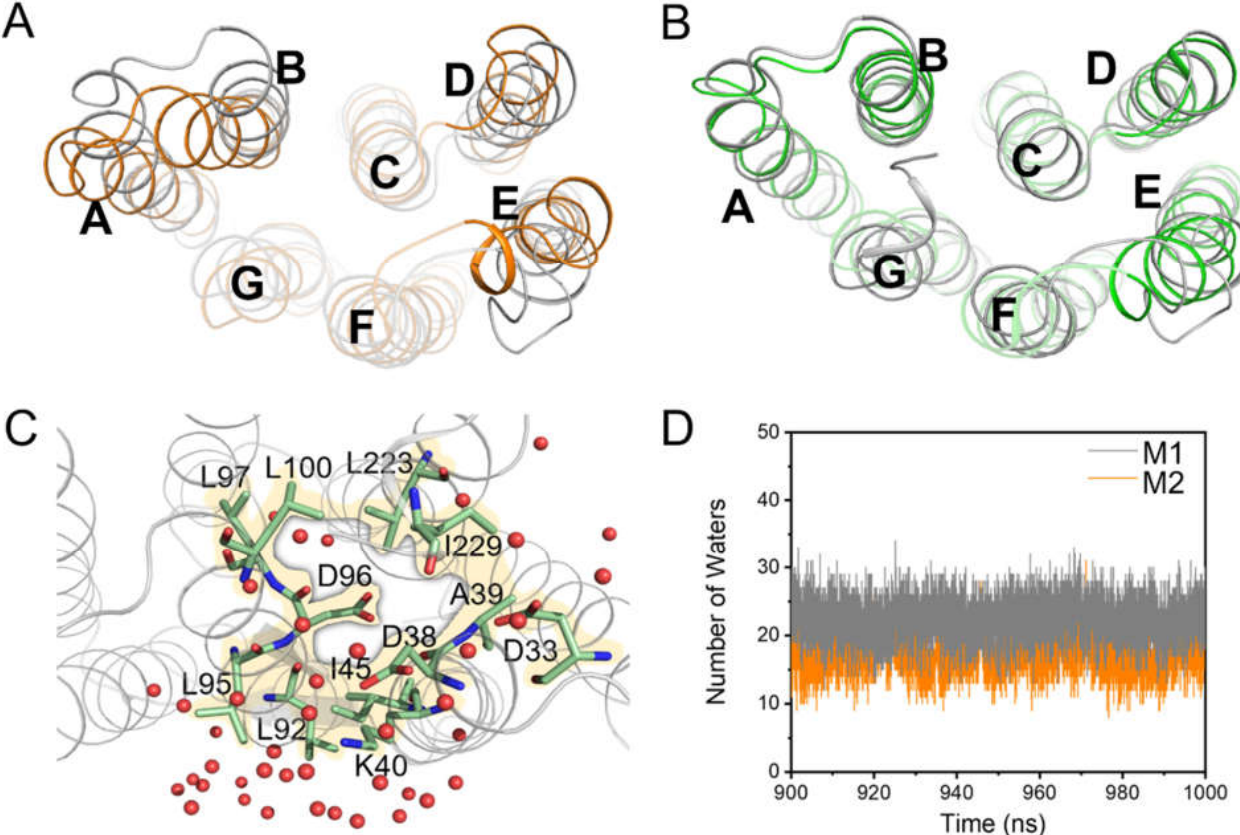
Figure 9. Dynamic changes in helices and water molecules on the cytoplasmic surface by the PGP-Me. ( A ) Superimposed drawing of the cytoplasmic side protein conformation of M1 (grey cartoon) and M2 (orange cartoon); ( B ) M1 and the late M state crystal structure of bR (PDB ID: 1FBB, green cartoon); ( C ) schematic diagram of the distribution of water molecules on the cytoplasmic surface from the last snapshot of M1. Red spheres represent the water molecules. D96 is surrounded by the key residues, especially hydrophobic ones (green stick and yellow surface). More water molecules gather around these residues, making it more accessible for them to enter the protein efficiently during the M state; ( D ) time series of the number of water molecules near the cytoplasmic surface in the last 100 ns simulations of M1 (grey line) and M2 (orange line).